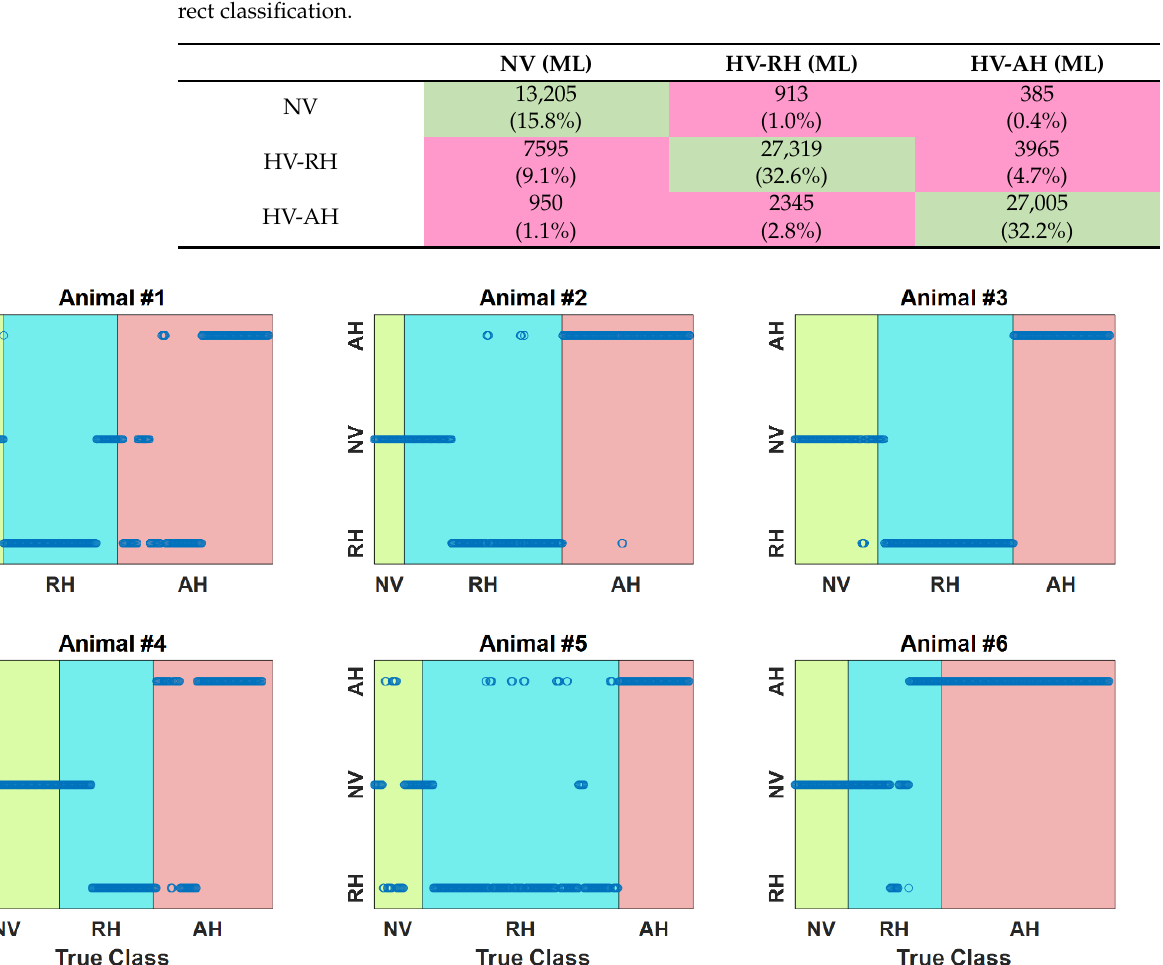
Table 4. Confusion matrix associated with the multi-class classifier (1st-stage random forest and 2nd-stage logistic regression). Green cells indicate correct classification. Pink cells indicate incor- rect classification.